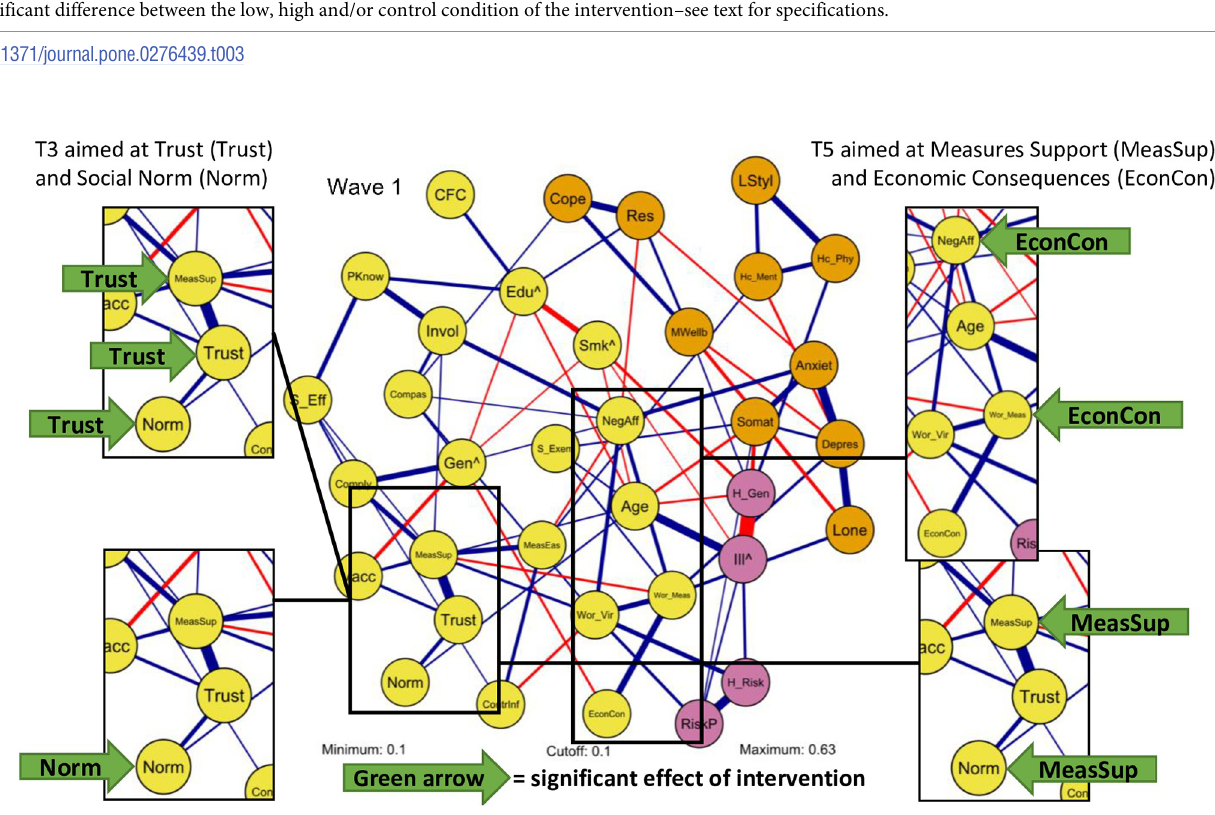
Fig 4. Visualization of significant effects of interventions on nodes in the broad COVID–19 attitude network. See Fig 3a for node legend. The green arrow indicates a significant effect with the specific intervention included in the arrow. Note that the broad COVID–19 attitude network is based on participants from the first wave and not the wave in which interventions were